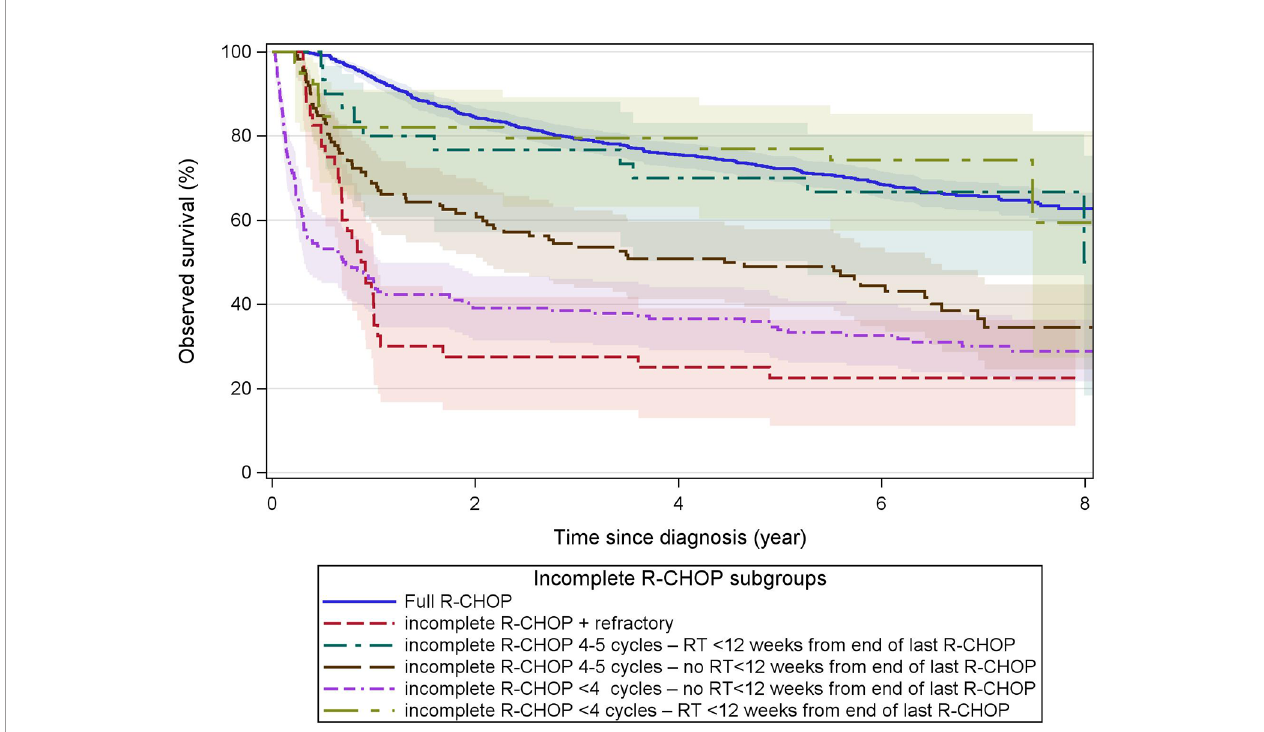
FIGURE 3 | Observed survival after incomplete R-CHOP. These Kaplan – Meier curves show the observed survival from diagnosis of patients receiving fi rst-line treatment with incomplete R-CHOP (< 6 cycles or < 4 cycles if Ann Arbor stage = I, or CHOP without R) grouped by refractory status (start of any second-line treatment within 12 weeks from the end of fi rst-line therapy), number of R-CHOP cycles, and radiotherapy within 12 weeks from the end of the last R-CHOP cycle. Primary refractory cases had the worst survival. The overall survival of incomplete R-CHOP followed by radiotherapy (green curves) was similar to that of full-R-CHOP. Immortal time bias is not taken into account as survival is presented from diagnosis and patients have to survive until the end of a treatment to be categorized as having received this treatment. Colored areas represent the 95% con fi dence intervals.